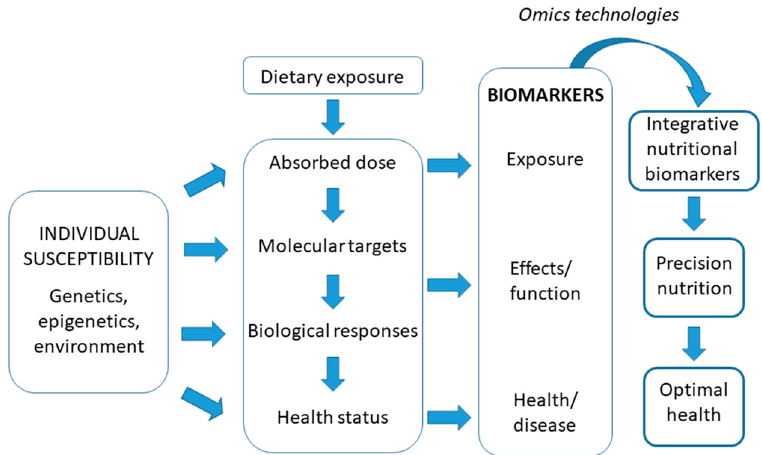
Figure 1. Integrative nutritional biomarkers and their interest in precision nutrition. Biomarkers of exposure include biological markers intended for the assessment of dietary food intake, whereas biomarkers of e ff ect / function are related to target function or biological response. These biomarkers reflect not only the intake but also the metabolism of nutrients and, possibly, e ff ects on disease processes. Biomarkers of health / disease are biomarkers of ultimate goal and indicative of improved health status and / or reduced risk of disease. Several factors (genetic, epigenetic, environment, etc.) can a ff ect the individual response to dietary intake and its relation to health status. There is a great interest in the development of new types of nutritional biomarkers with an integrative trait, indicative of the intake and e ff ects on the organism, including its relationship with the state of health / disease and omics technologies may play a relevant